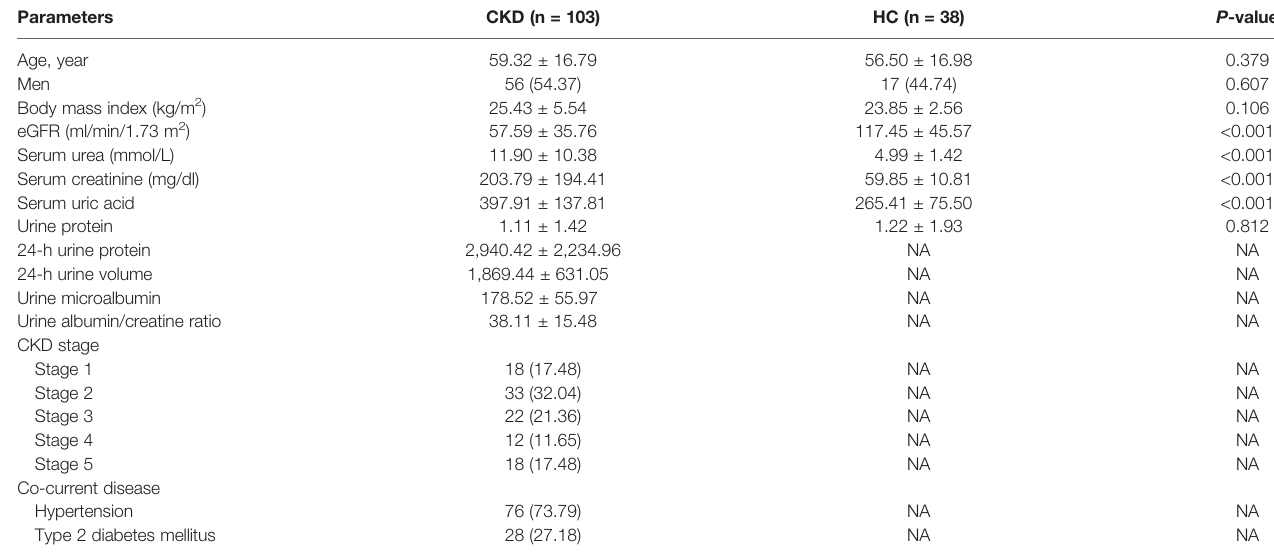
TABLE 1 | Characteristics of the participants.